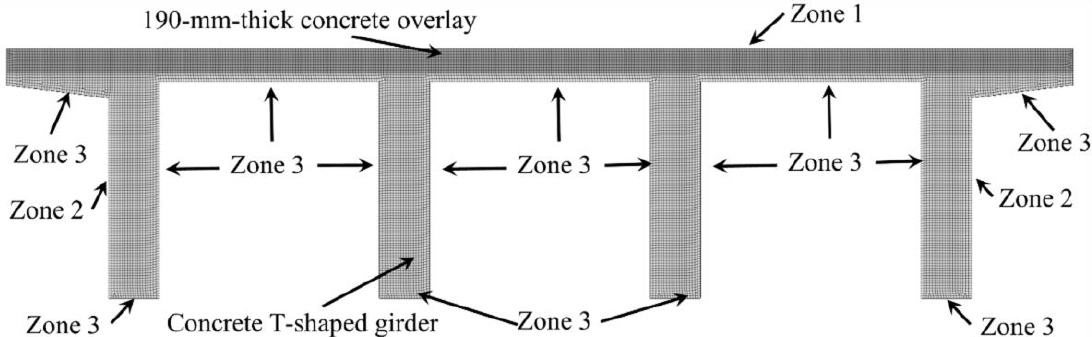
Figure 19. Layout of cross-section of T-shaped girder (cm).